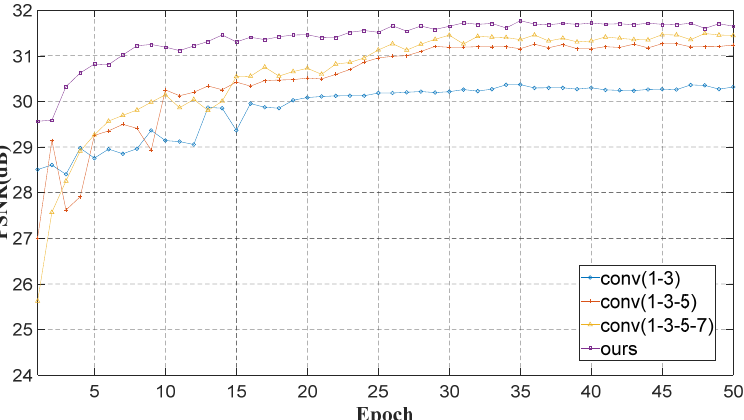
Figure 5. PSNR curves of various convolution filters.